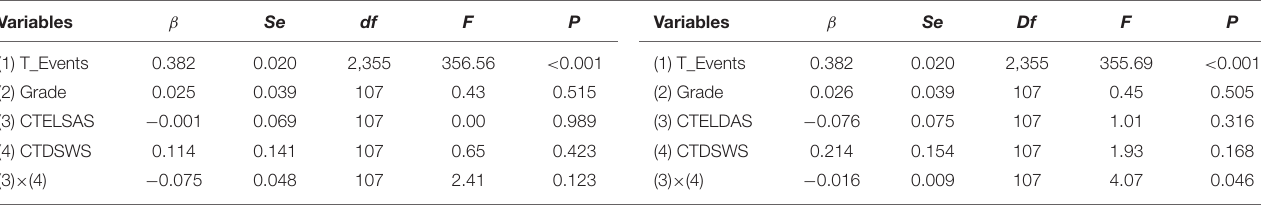
TABLE 4 | Cross-level interaction analysis of the multilevel model with emotional labor as the moderating variable. Variables β Se df F P Variables β Se